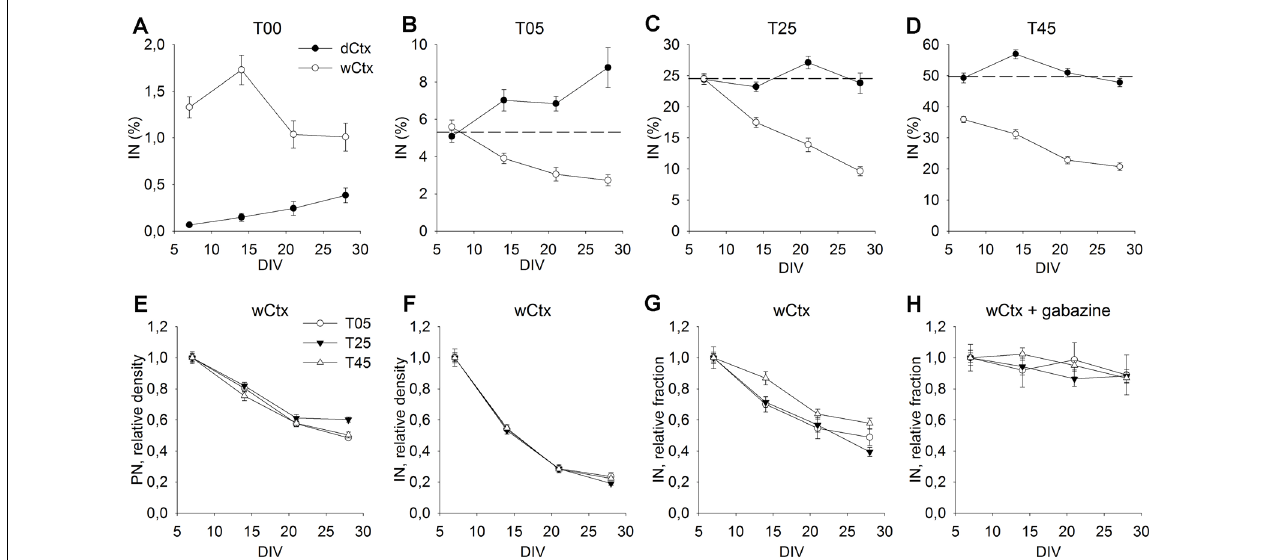
FIGURE 6 | Cellular composition of dCtx and wCtx networks during maturation. The graph in (A) shows the MGE-IN fraction of T00 networks derived either from the dorsal cortex (dCtx) or whole cortex (wCtx) of wild-type E16 rat embryos. In (B–D) the MGE-INs fraction of dCtx and wCtx networks is shown for T05 (B) , T25 (C) , and T45 (D) cultures. On wCtx the fraction of MGE-INs declined with age in all cases, while on dCtx it increased in T05, but remained stable in T25, T45 network types. (E–H) The values normalized to 7 DIV allow to compare the population dynamics of PN (E) , IN (F) , and %IN (G) in wCtx T05, T25, and T45 cultures. The faster decline in the IN fraction (E–G) was abolished in the presence of the GABA antagonist Gabazine (H) . Dotted lines in (B–D) show the normalized 7 DIV value for